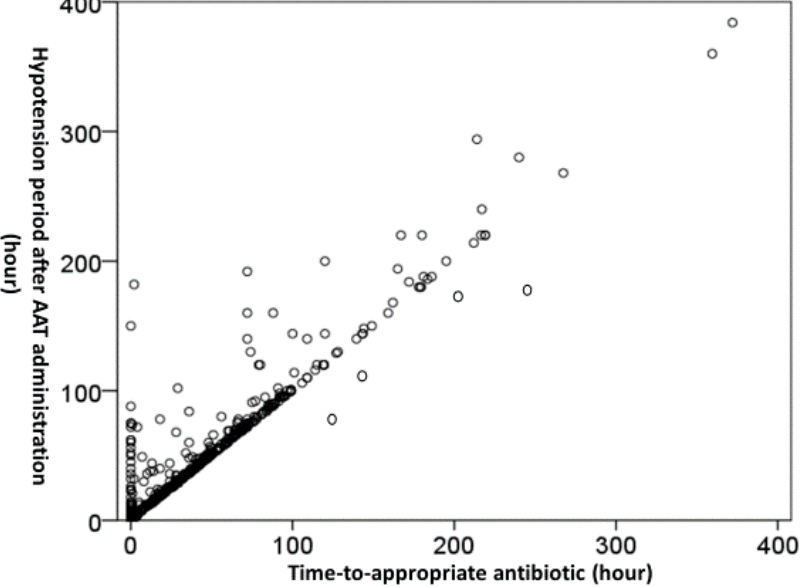
Figure 2. A linear-by-linear association ( γ = 0.839, p < 0.001) of the time-to-appropriate antibiotic and the hypotension period after AAT initiation, tested by Pearson’s correlation. AAT = appropriate antimicrobial therapy.